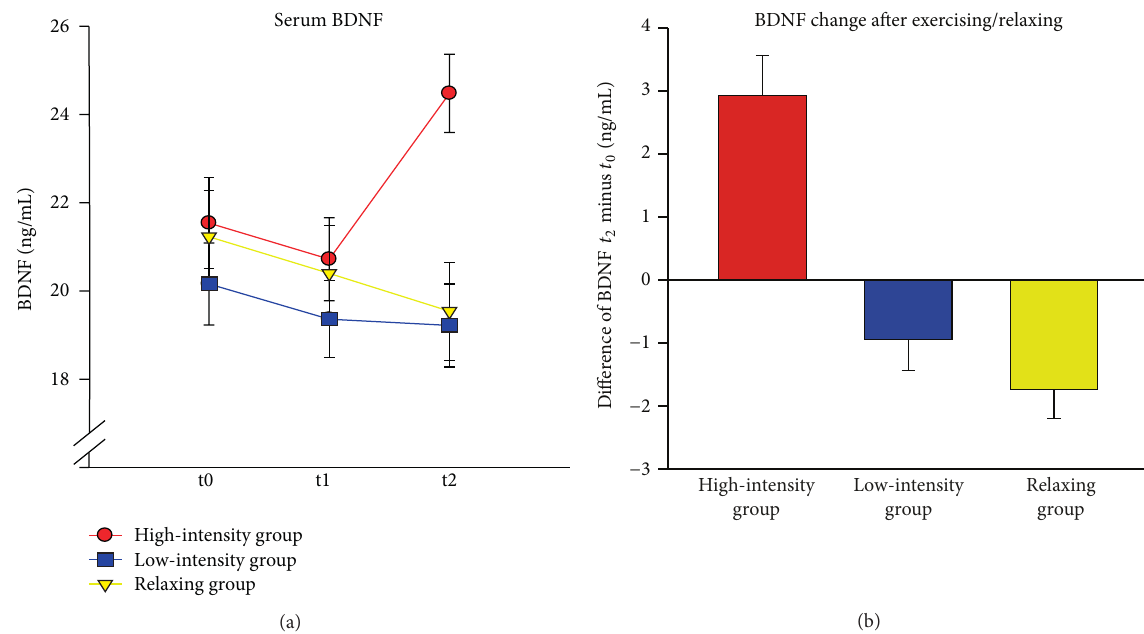
Figure 3: (a) Mean serum BDNF at baseline ( 𝑡 0 ), after learning ( 𝑡 1 ), and after exercising/relaxing ( 𝑡 2 ) separately for the high-intensity exercise group, the low-intensity exercise group, and the relaxing group. (b) Mean changes in BDNF from baseline to the assessment after exercising/relaxing. Positive values indicate an increase in BDNF. Error bars depict ± 1 standard error of the mean.